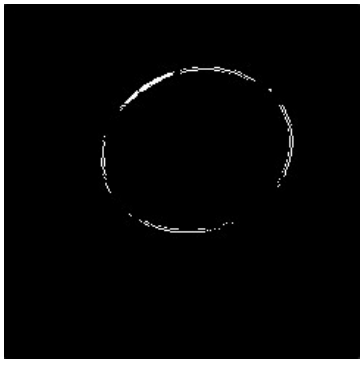
Figure 40. Pupil elliptical vertex image.